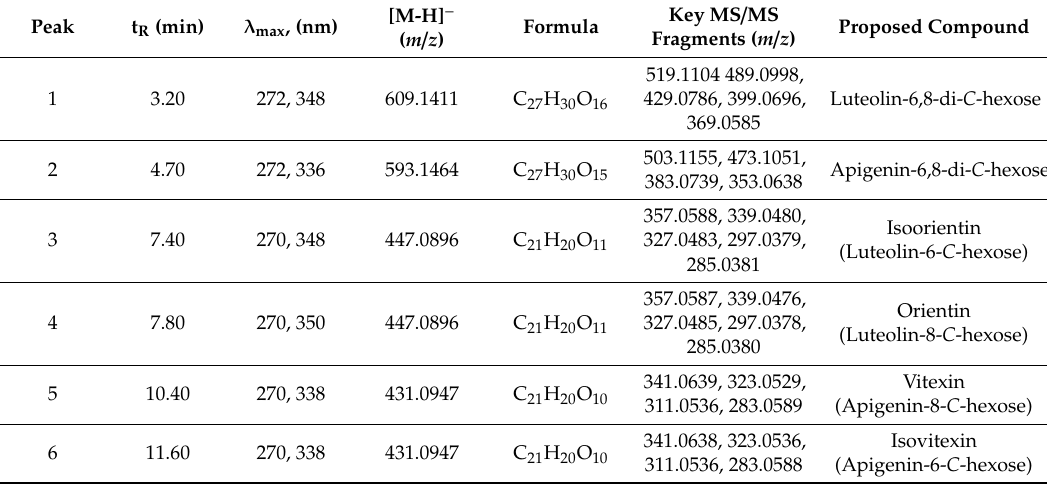
Figure 6. UHPLC–UV/PDA chromatogram of acid hydrolysed OPL extract at 340 nm with assigned chemical structures. Peak assignment: 1, luteolin-6,8-di- C -hexose; 2, apigenin-6,8-di- C -hexose; 3, isoorientin; 4, orientin; 5, vitexin and 6, isovitexin. Peaks 3–6 were confirmed by commercial standards. uAU stands for micro-Absorbance Units. Table 2. Identification of flavonoid C -glycosides after acid hydrolysis by UHPLC–UV / PDA and LC–MS /